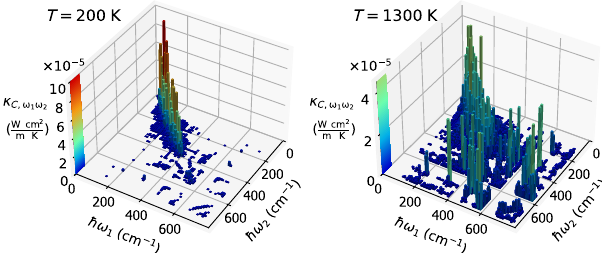
FIG. 5. Two-dimensional density of states for the thermal conductivity, κ C; ω , which resolves how much a Zener-like 1 ω 2 coupling between two vibrational modes having frequencies ω 1 , ω ’ conductivity. We show κ 2 contributes to the coherences C; ω 1 ω 2 at 200 K (left-hand panel) and at 1300 K (right-hand panel). The points close to the diagonal ω 1 ∼ ω 2 correspond to quasidegen- erate vibrational eigenstates; the Allen-Feldman framework considers couplings only between